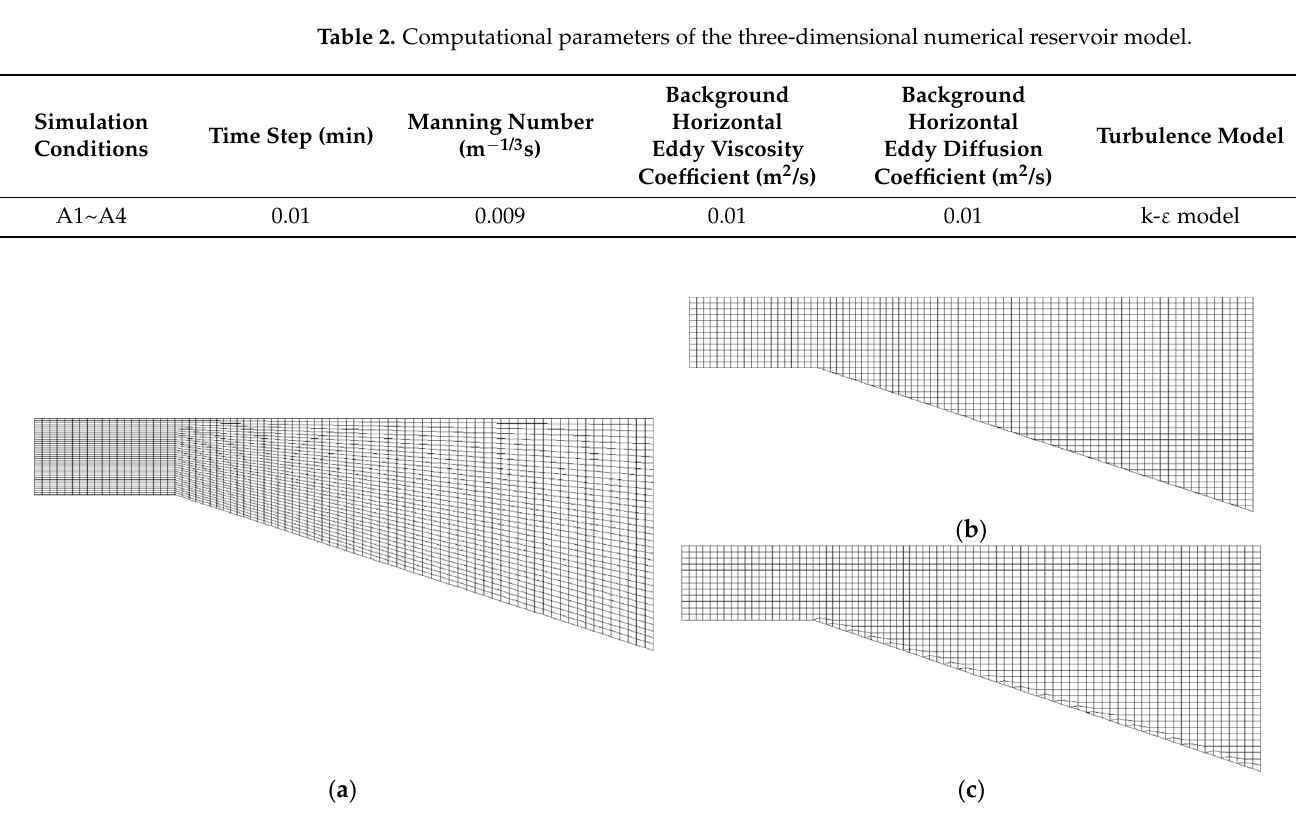
Figure 2. Sketch of vertical grids for different simulation conditions. ( a ) A1, A2. ( b ) A3. ( c ) A4.